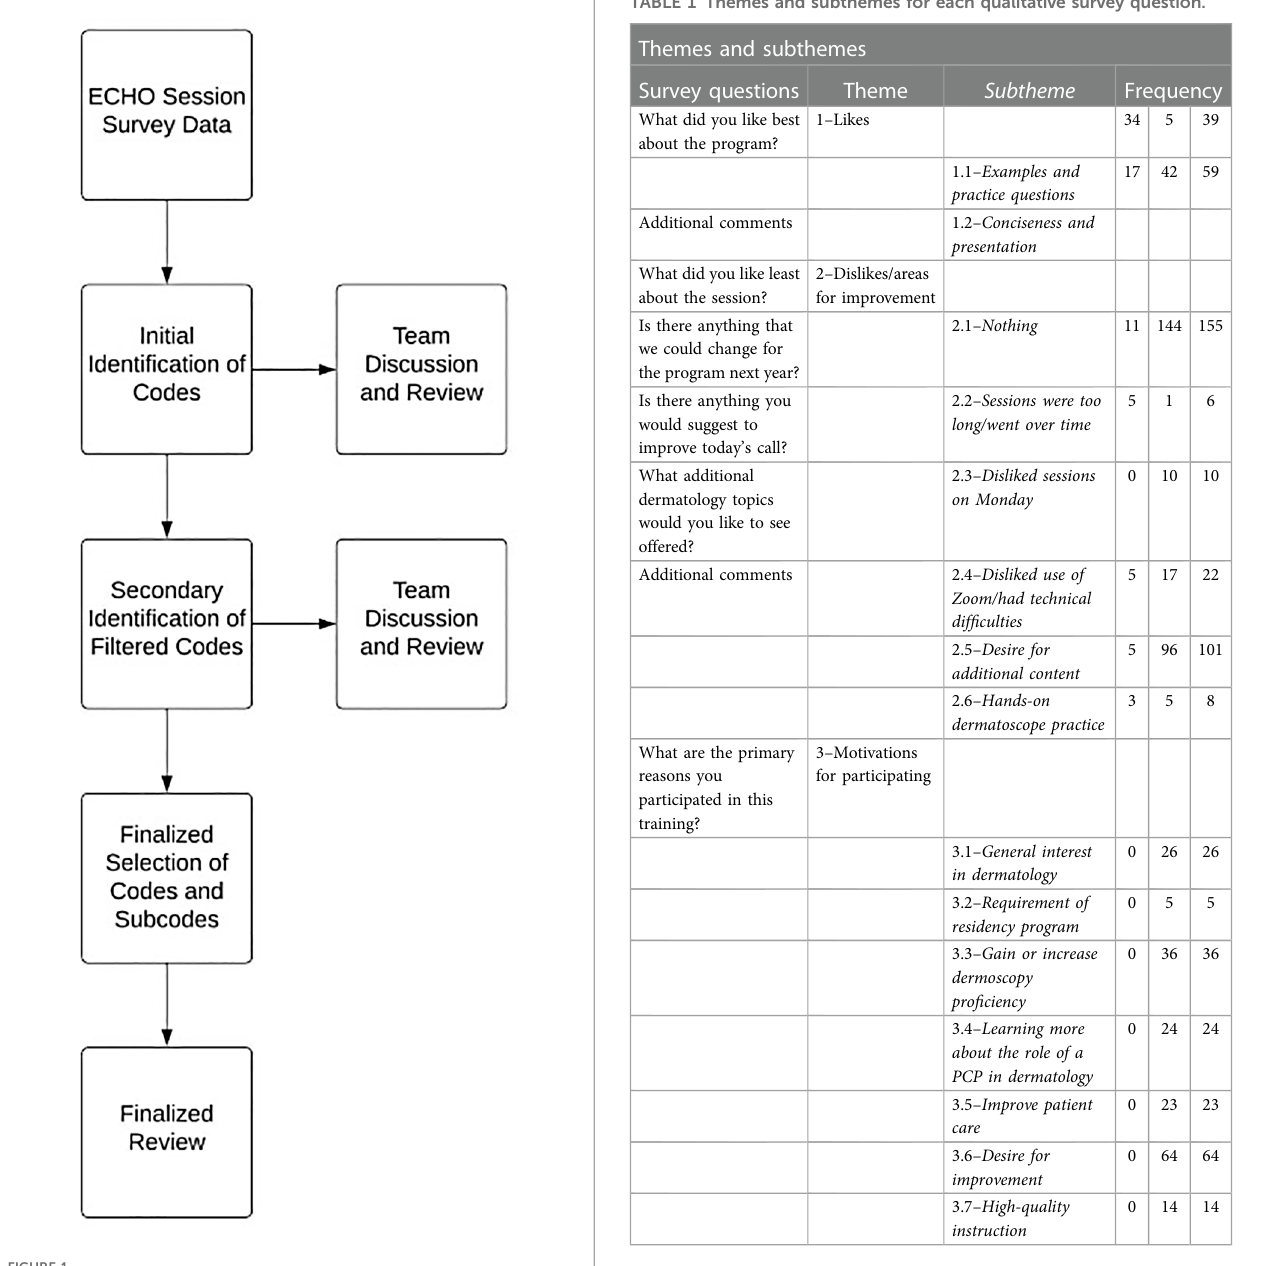
TABLE 1 Themes and subthemes for each qualitative survey question.